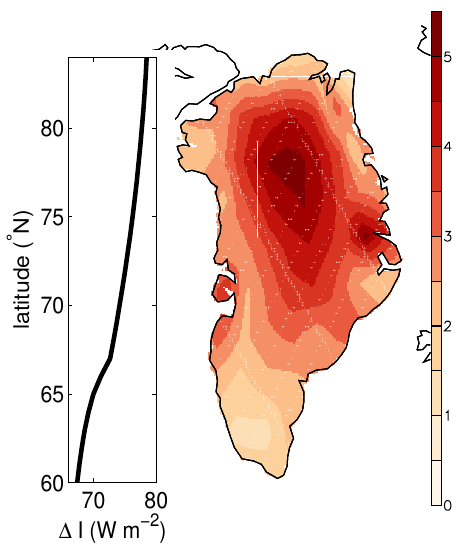
Fig. 3. Difference 126ka–0ka in summer insolation (left) and JJA surface air temperature in IPSL CM4 (in ◦ C, right ).